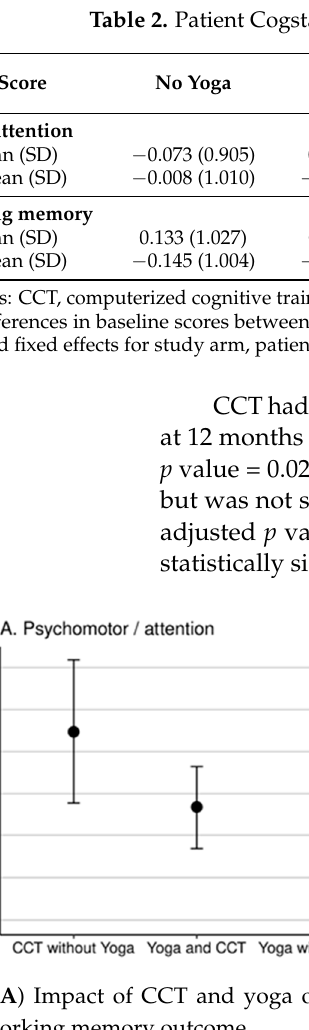
Table 2. Patient Cogstate composite scores at baseline and 12 months follow-up.